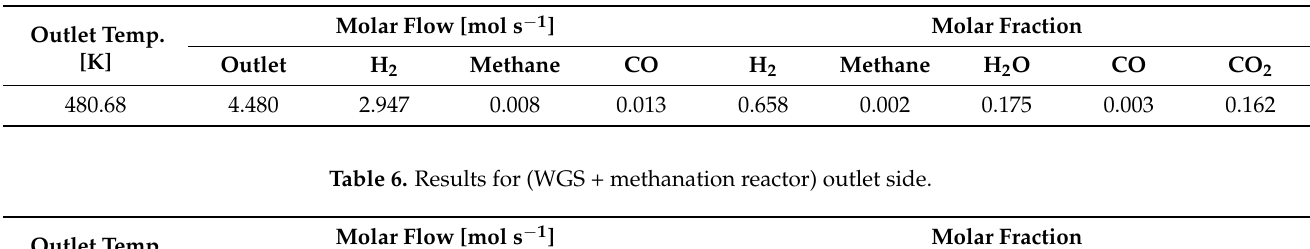
Figure 8. Schematic of Case 5 reforming system. 3.3. Results Analysis Table 8 shows the results of the calculation of the molar flow rate and molar fraction at the outlet side of each post-treatment system according to the components.